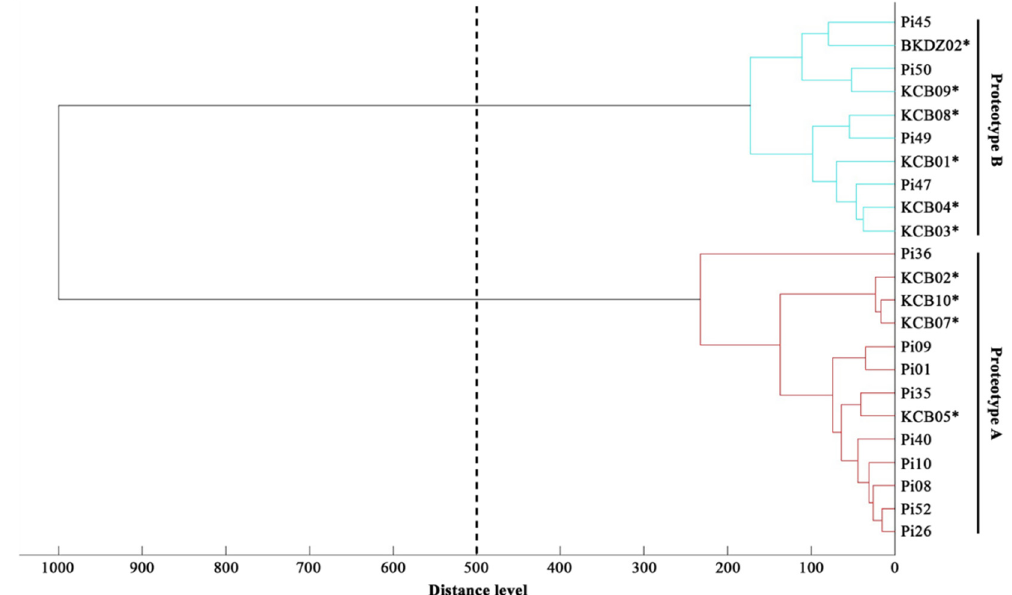
Figure 5. Proteomic dendrogram of water-isolated and clinical strains of P. insidiosum . The main spectral profiles (MSP) of 10 water-isolated (4 Clade-II and 6 Clade-III genotype strains; Table 2) and 13 clinical (4 Clade-I, 5 Clade-II, and 4 Clade-III genotype strains; Table 3) strains of P. insidiosum are recruited for the construction of a dendrogram. The distance value of 500 is used as the cut-off value for proteotyping of the organisms. Asterisks indicate water-isolated strains of P. insidiosum.